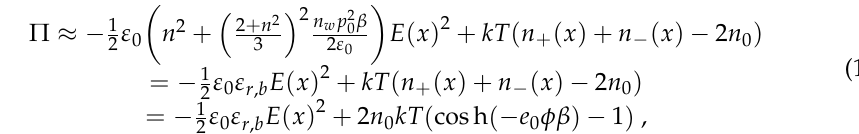
Figure 7. Schematic figure of an electrolyte solution between two charged surfaces at the distance H , where the surface charge densities 𝜎 (cid:2869) < 0 and 𝜎 (cid:2870) > 0 . For small values of 𝛾𝑝 (cid:2868) 𝐸(𝑥)𝛽 everywhere in the solution between the two charged surfaces, we expand the third and fourth term in the above Equation (9) into series to